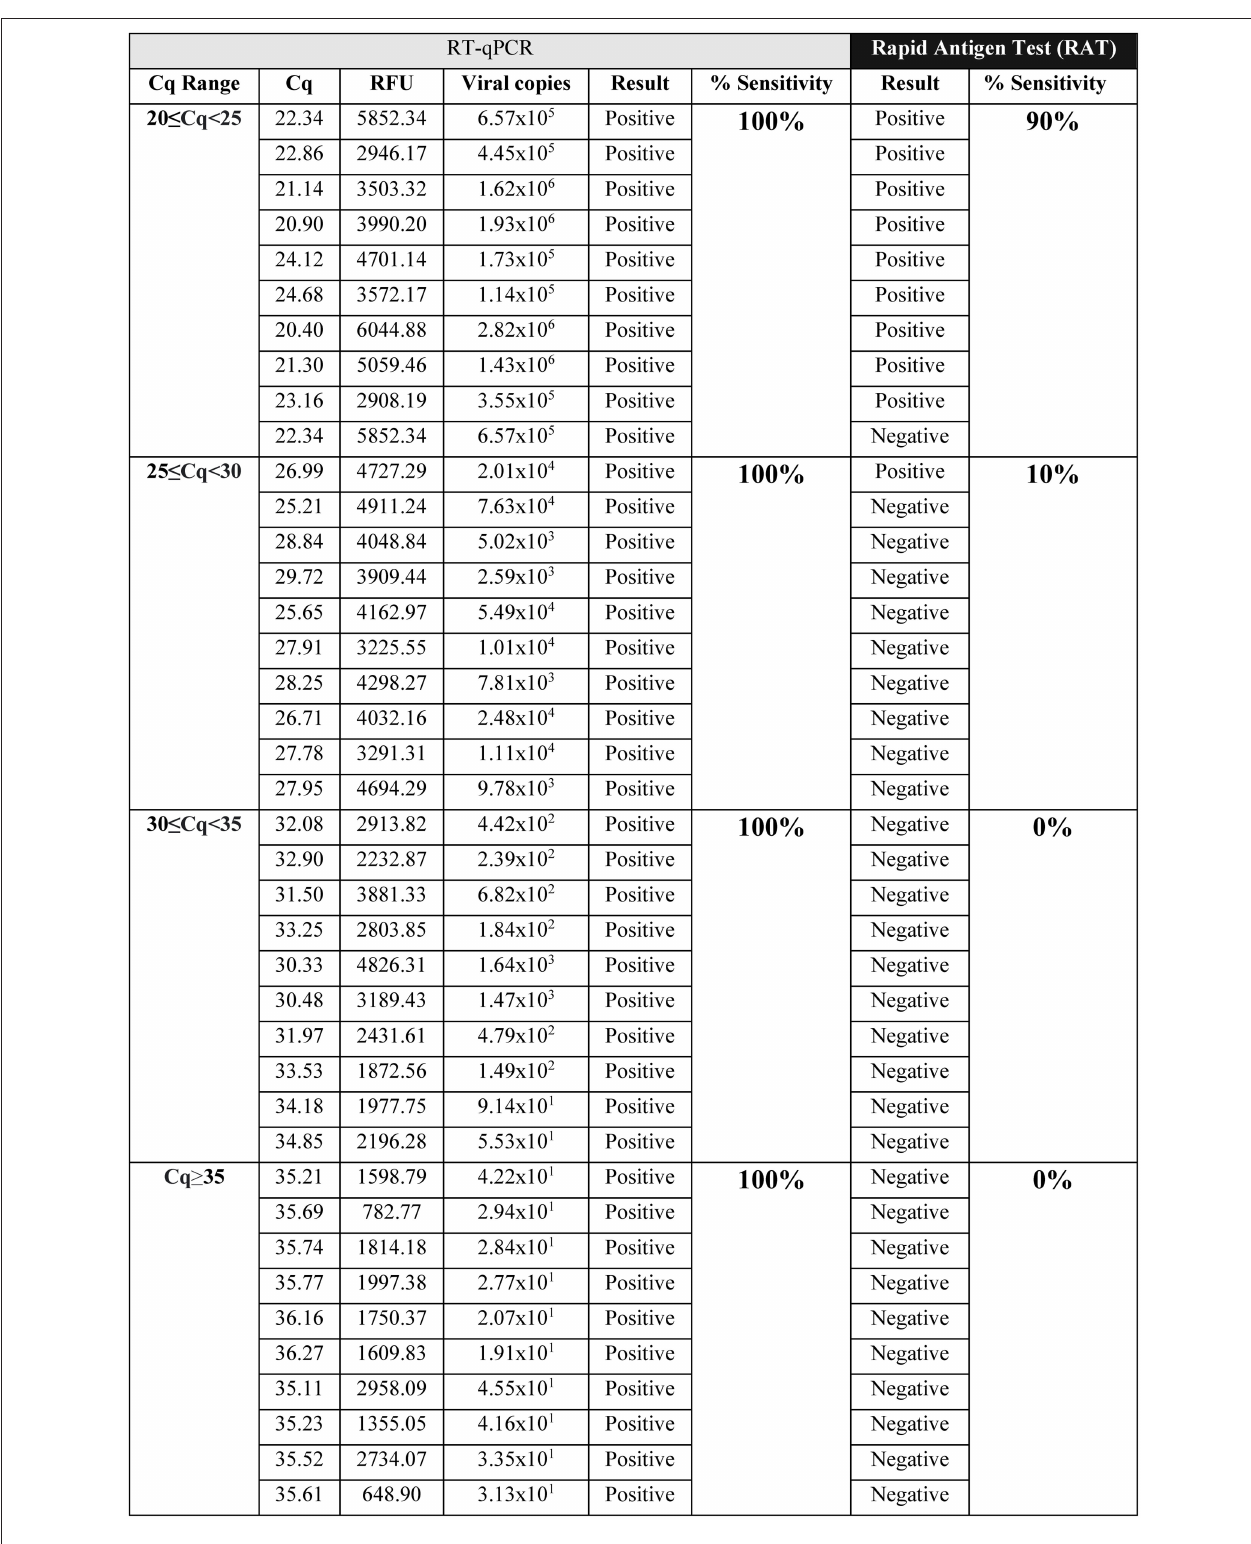
FIGURE 1 | Sensitivity evaluation of the rapid antigen test (RAT; SD BIOSENSOR, South Korea) at different ranges of Cq values for ancestral strain of SARS-CoV-2 positive samples diagnosed by RT-qPCR. SARS-CoV-2 detection by RAT from RT-qPCR positive samples with Cq value between 20 ≤ Cq < 25, 25 ≤ Cq < 30, 30 ≤ Cq < 35, and Cq ≥ 35, respectively. All samples were positive by RT-qPCR. Table shows: the RFU (relative fluorescence units) and Cq value for the viral ORF1ab probe ( n = 10 samples per Cq range).